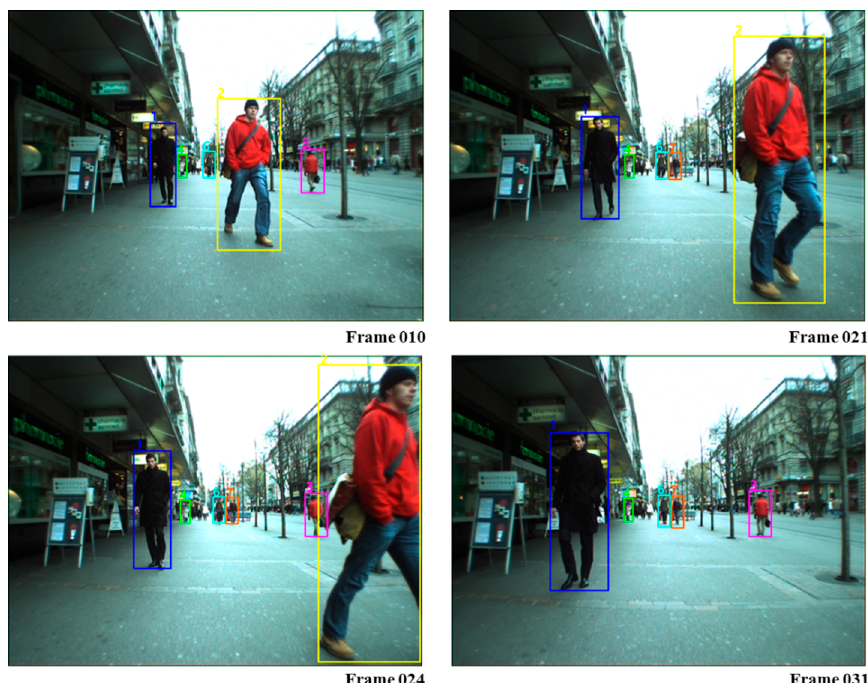
Figure 7. Tracking results of our system on ETH.